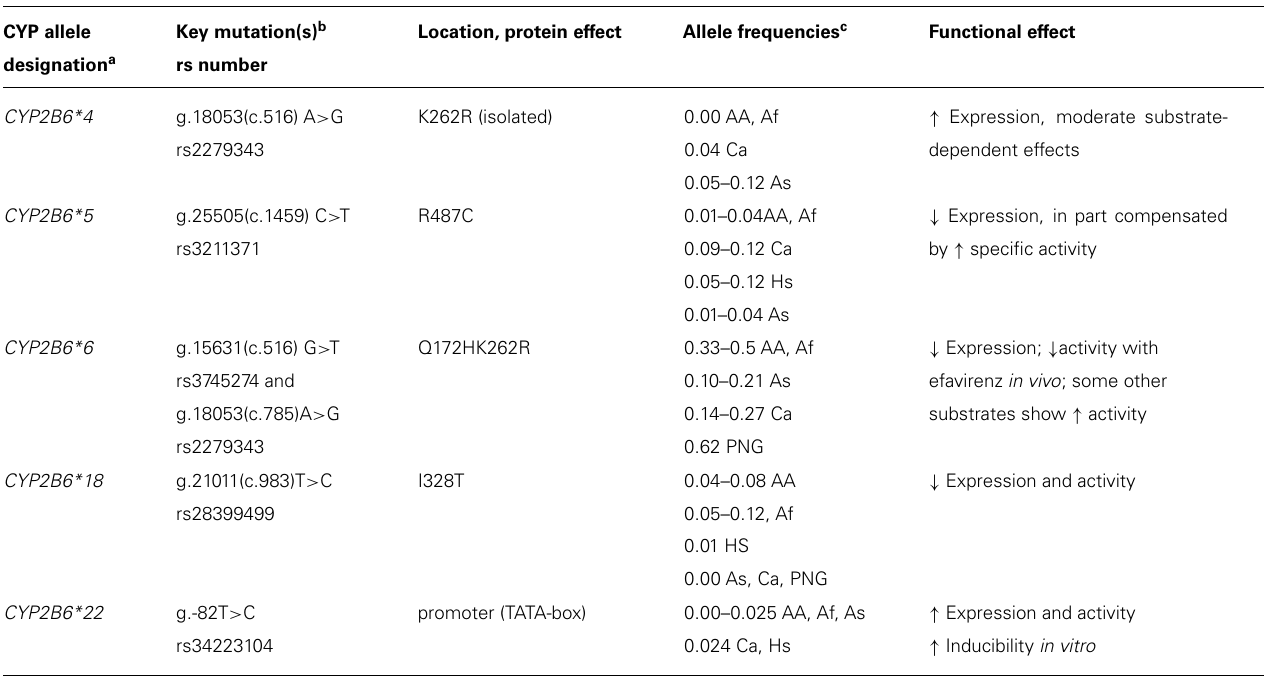
Table 1 | Summary data on selected genetic polymorphisms of CYP2B6 .